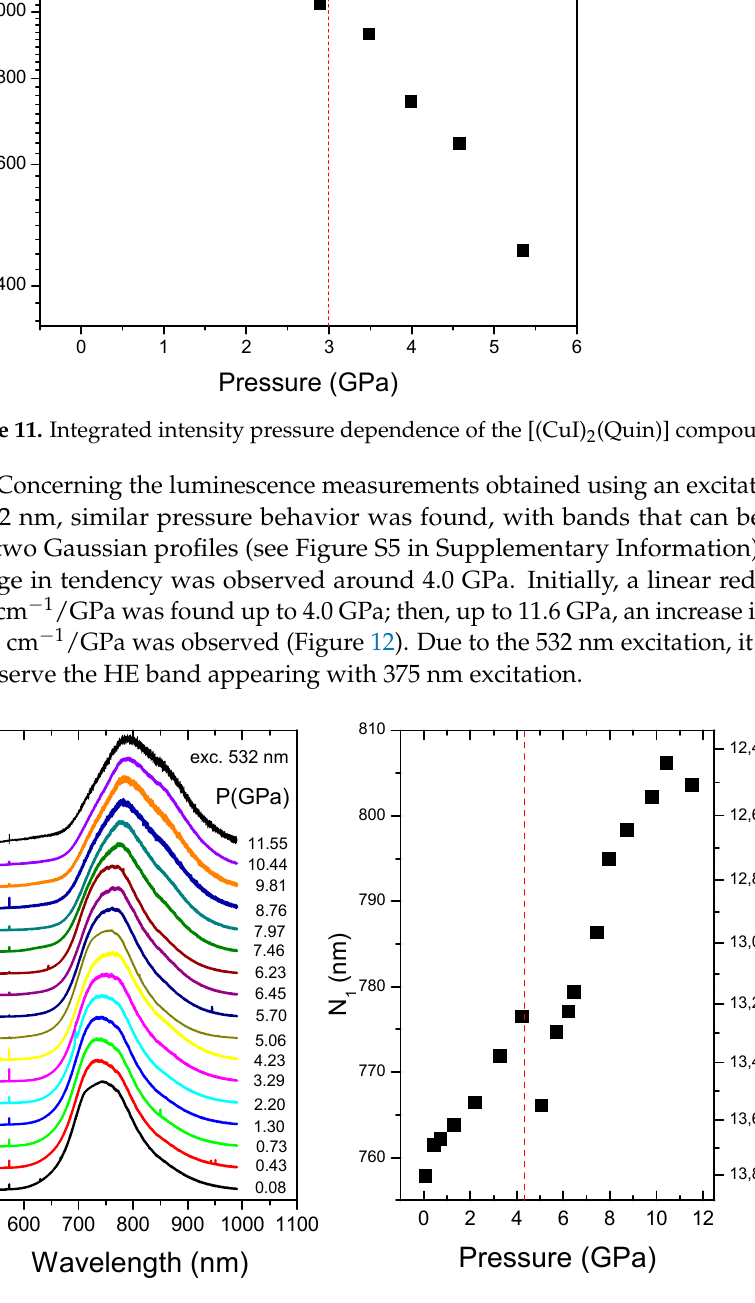
Figure 10. Pressure dependence of luminescence spectra of [(CuI) 2 (Quin)] compound obtained at ambient temperature under 375 nm laser excitation.